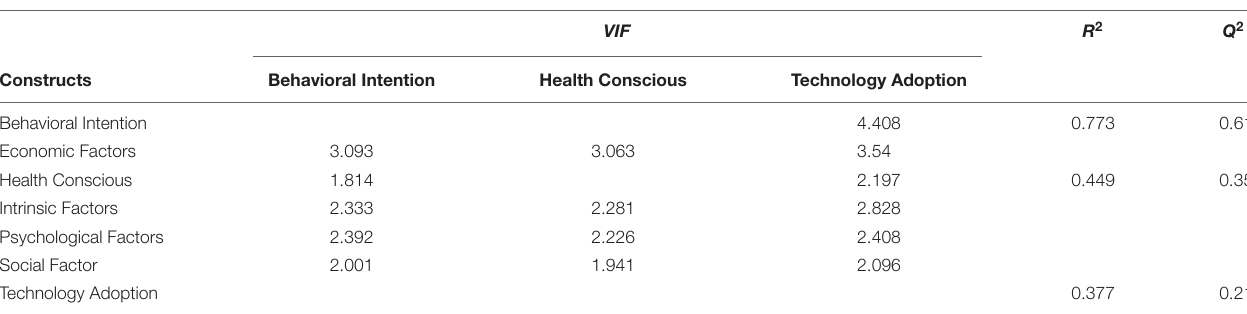
TABLE 5 | Variance inflation factor, coefficient of determination and predictive